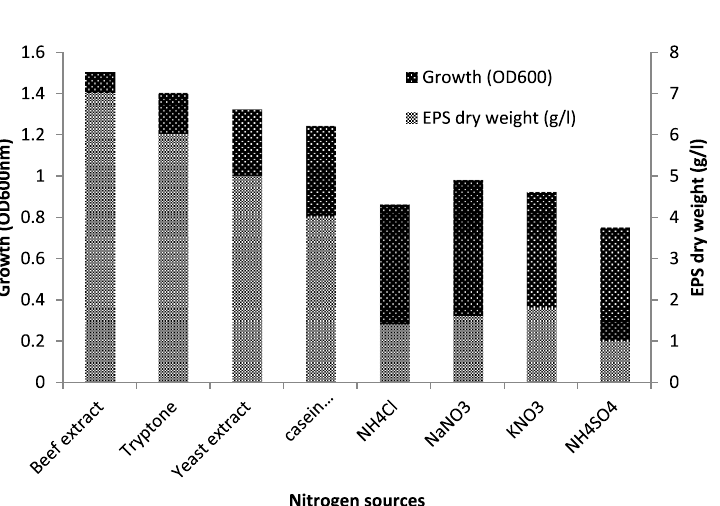
Fig. 3. Effect of different sources of nitrogen on growth and EPS production by Halomonas sp. NASH. Fermentations were carried out in IRAM medium supplemented with 9g/l nitrogen source under continuous shaking (200 rpm) at 37°C and pH 8 with 1% (v/v) initial inoculum for 7